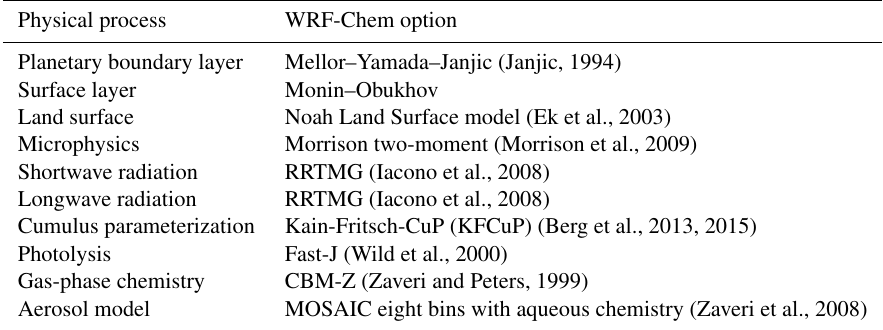
Table 1. Schemes and parameterizations used for the WRF-Chem